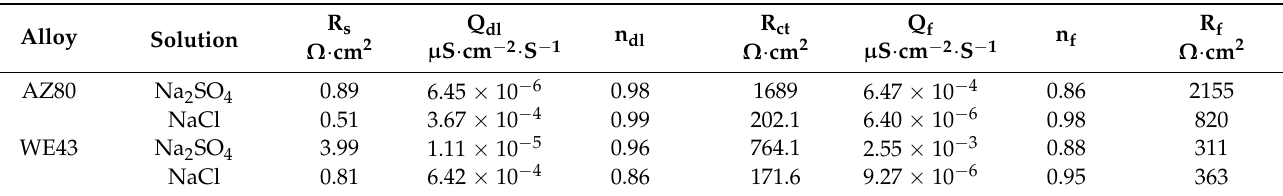
Figure 14. Equivalent circuit of EIS spectra. Table 5. The fitting EIS results of AZ80 and WE43 alloys immersed in NaCl and Na 2 SO 4 solution.